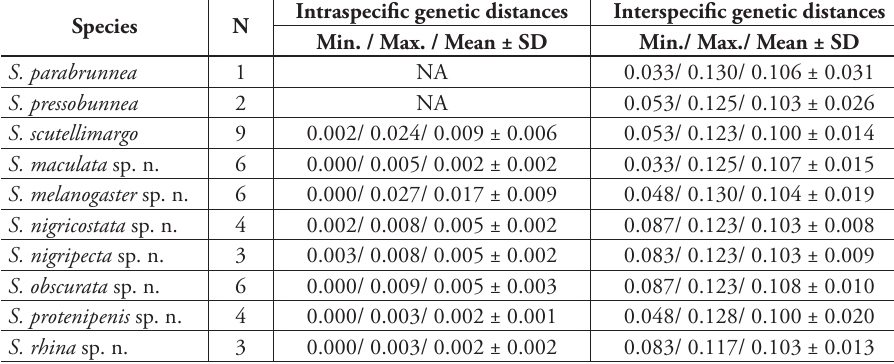
Table 2. Summary of intra- and interspecific genetic distances in the brunnea group.